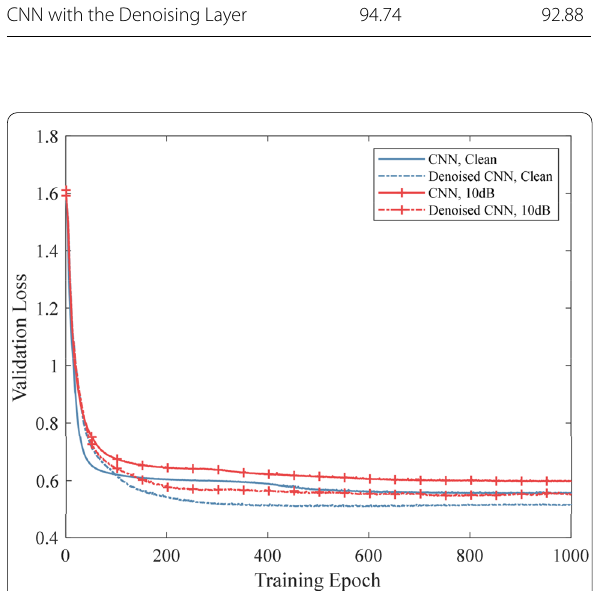
Figure 10 Variance of the validation loss on the planetary gearbox dataset based on